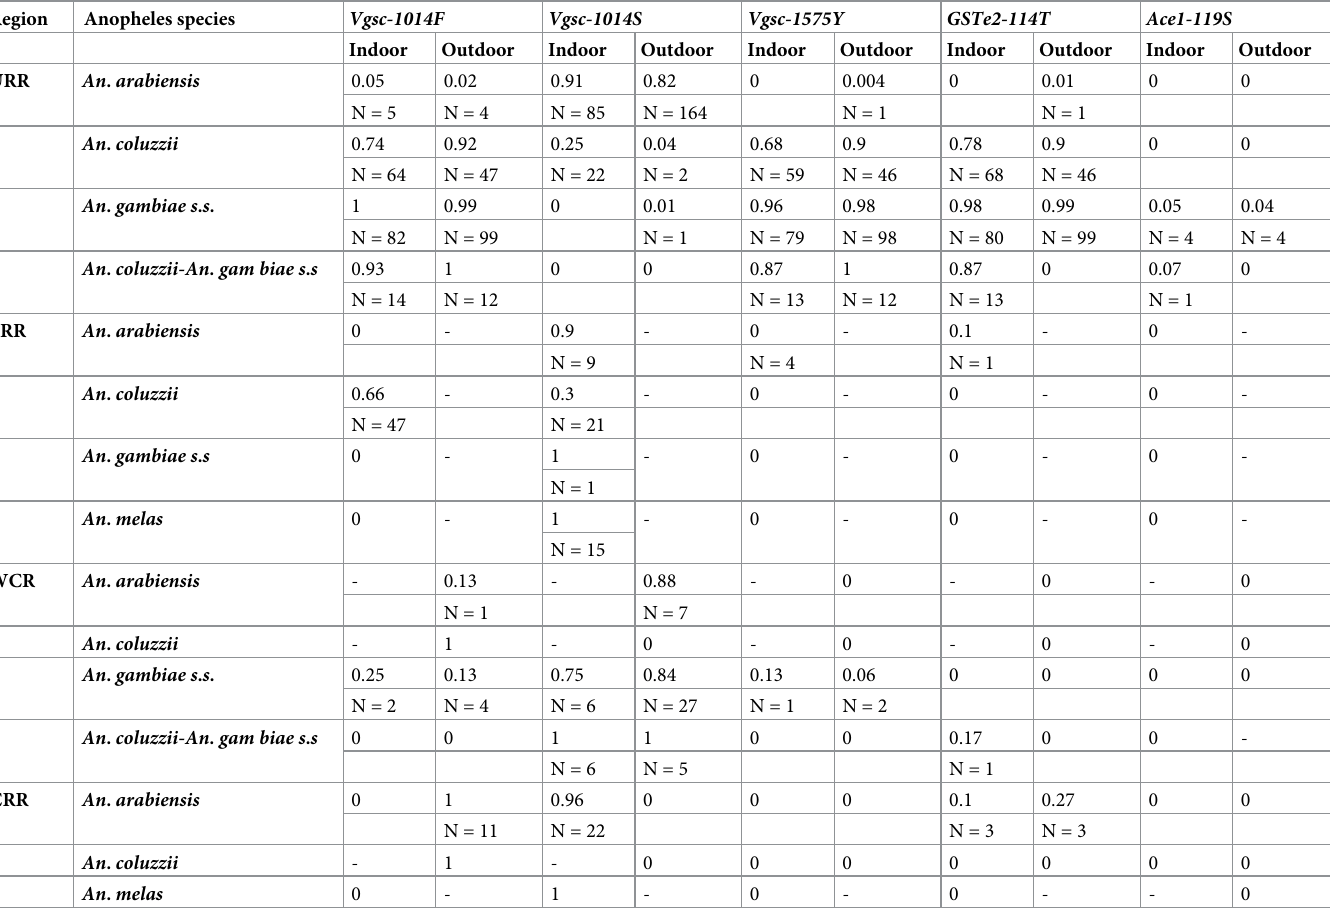
Table 1. Frequencies of insecticide resistance alleles on VGSC, GST and AChE loci in Anopheles gambiae s . l . populations from all study regions.